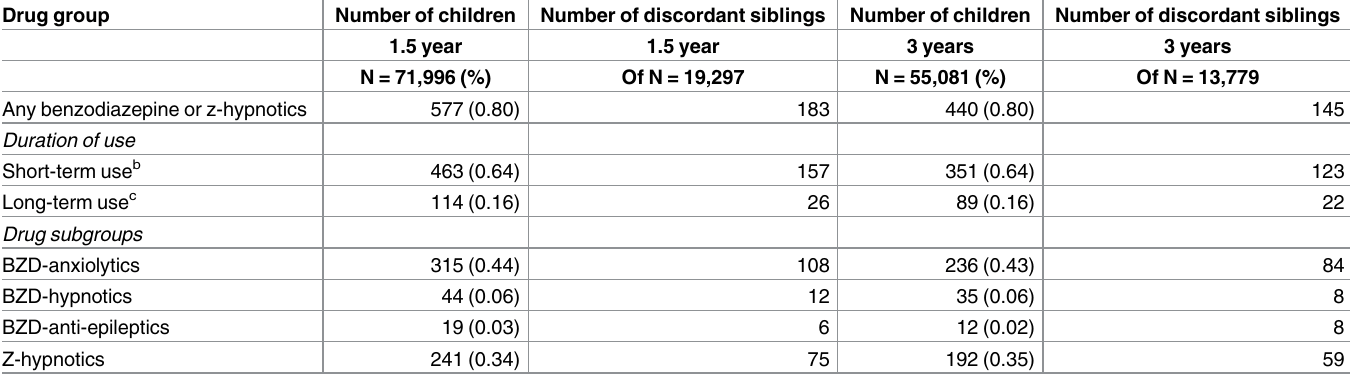
Table 1. Number of pregnant women reporting use of BZDs or z-hypnotics a